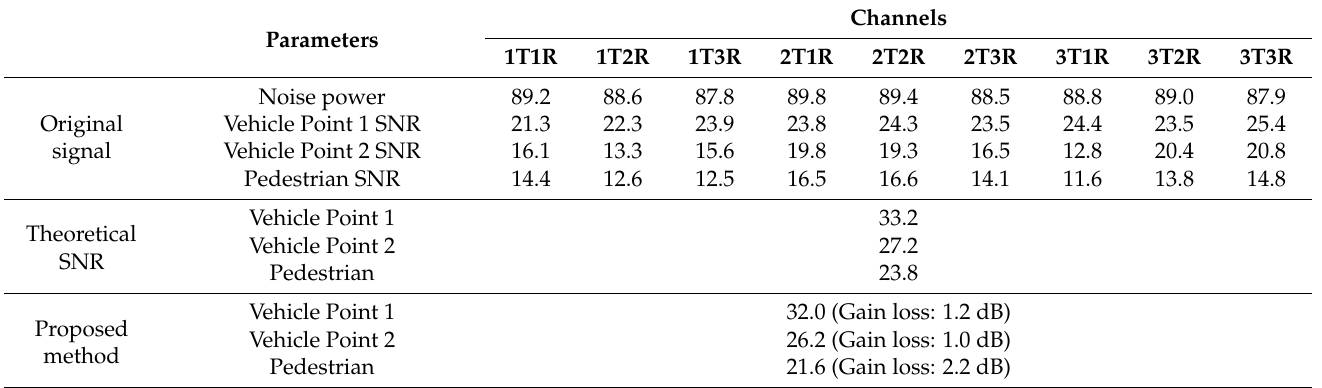
Table 7. The numerical comparison results (dB) with real